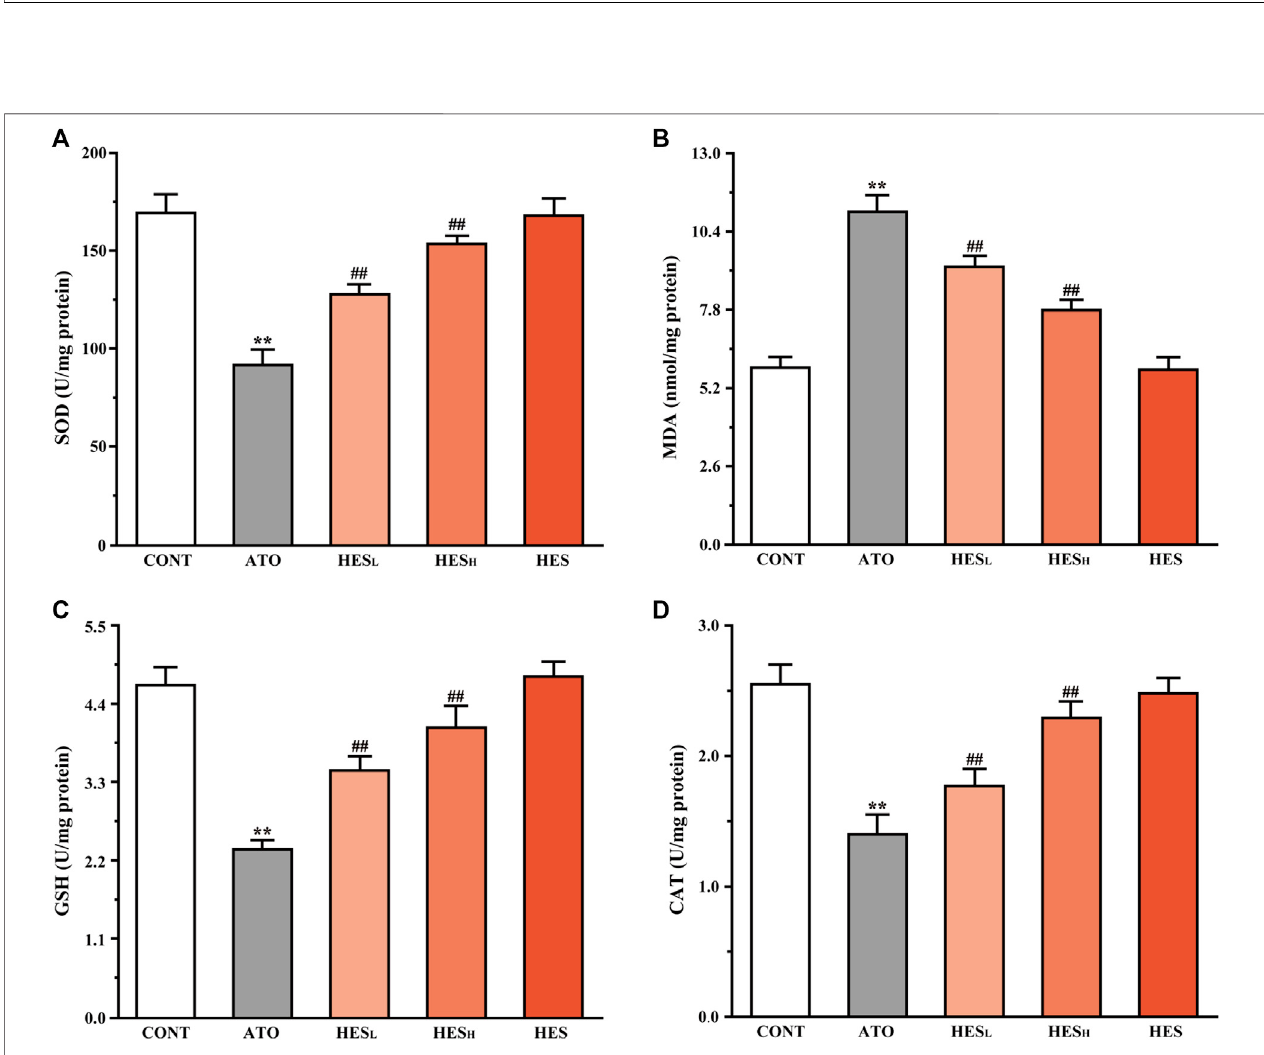
FIGURE 5 | Changes in SOD (A) , MDA (B) , GSH (C) , and CAT (D) expression between ATO group and HES groups. Results are expressed as mean ± SD ( n (cid:1) 6). ** p < 0.01, compared to CONT group, ## p < 0.01, compared to ATO group.